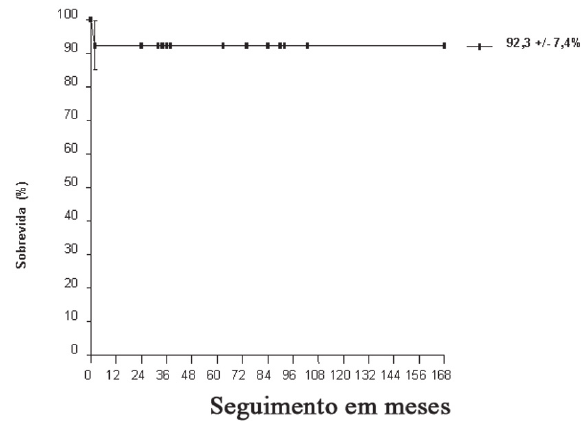
Fig. 3 - Sobrevida livre de reoperação